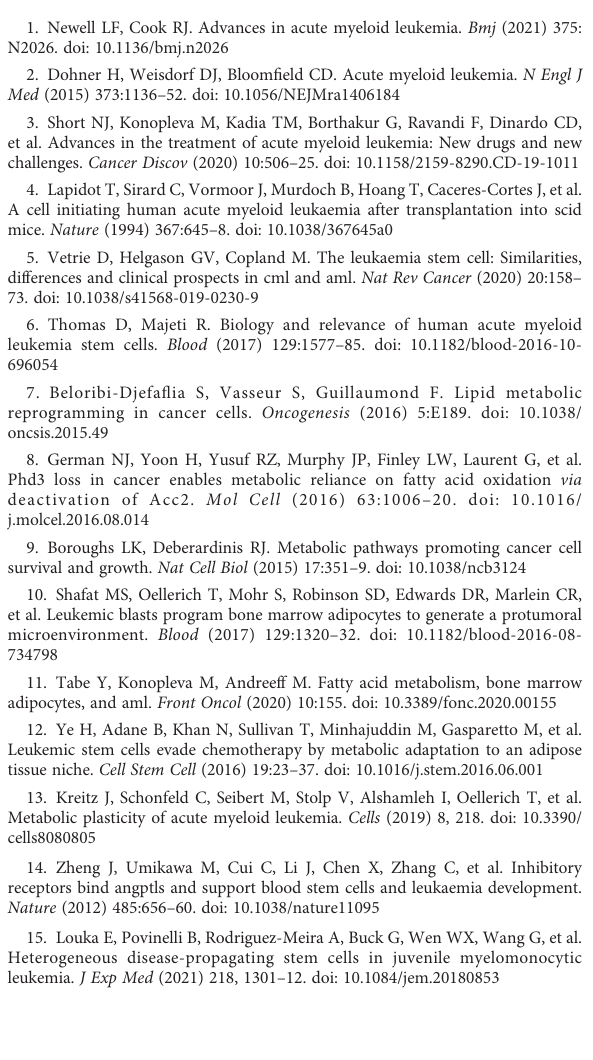
SUPPLEMENTARY FIGURE 1 Pseudotime trajectory analysis of the cells in the chemotherapy group. The pseudotime trajectory analysis of each cluster in the chemotherapy group.